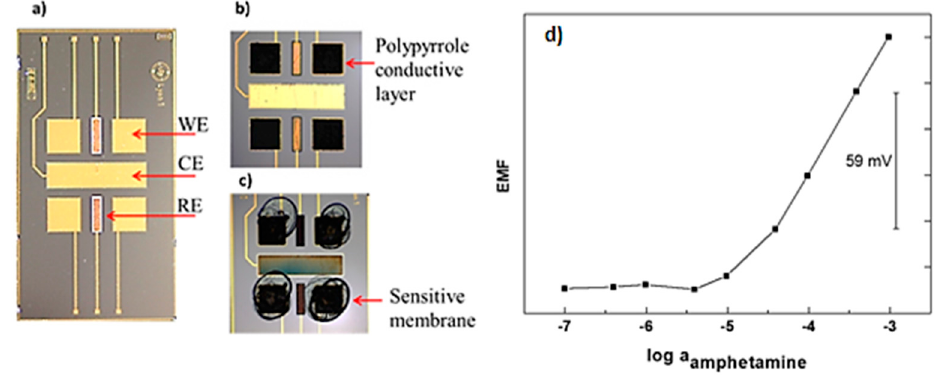
Figure 1. ( a ) transducer holding an array of four bare-gold working microelectrodes (WE), one bare-gold counter microelectrode (CE) and two Ag/AgCl reference microelectrodes (RE); ( b ) WEs electrochemically modified with polypyrrole solid conductive layer; ( c ) the polymeric membrane including the ion-par complex [C 9 H 13 NH] + [3,3 ′ -Co(1,2- closo -C 2 B 9 H 11 ) 2 ] − drop casted on the top of the WEs; ( d ) Potentiometric calibration curve of the amphetamine selective microelectrode developed.